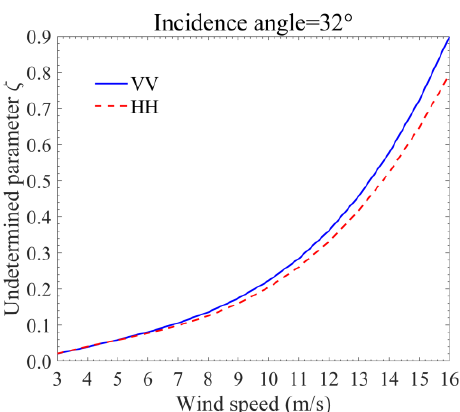
Figure 3. The variations of ζ with wind speed under VV and HH polarizations at the incidence angle of